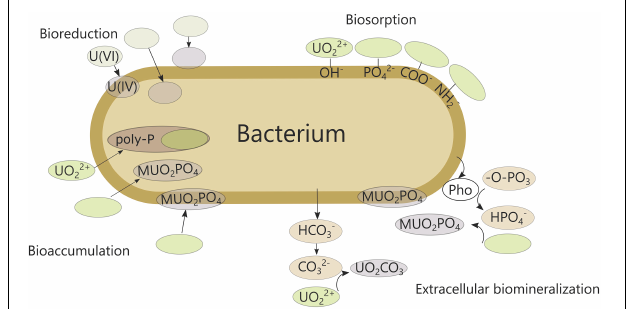
FIGURE 1 | Bacterial interactions with uranium. Uranium minerals are presented as UO 2 CO 3 or MUO 2 PO 4 with M indicating a metal ion. Pho, phosphatase; poly-P, polyphosphate